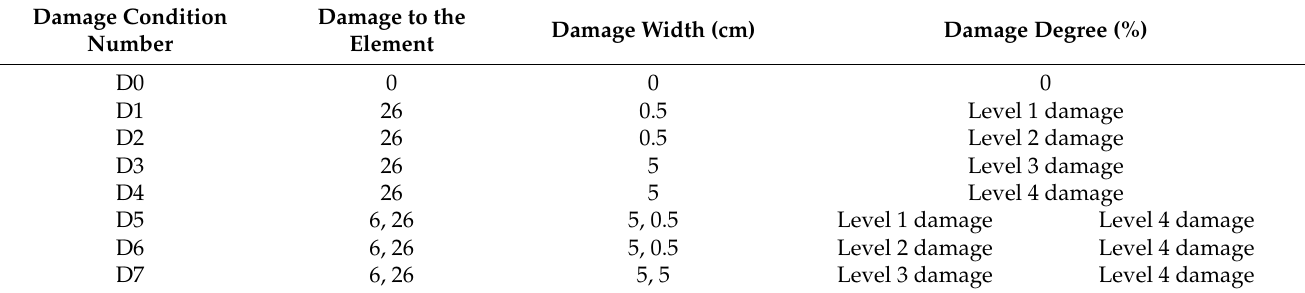
Figure 6. Sensor installation and experimental operation.